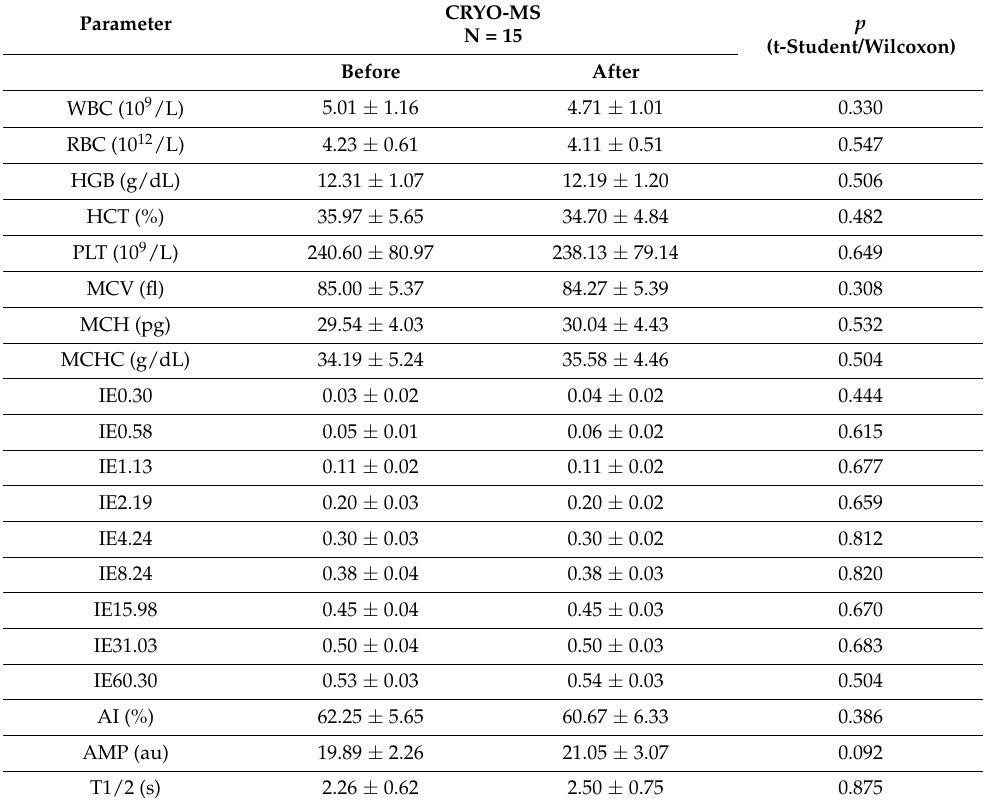
Table 4. Assessment of therapeutic intervention for